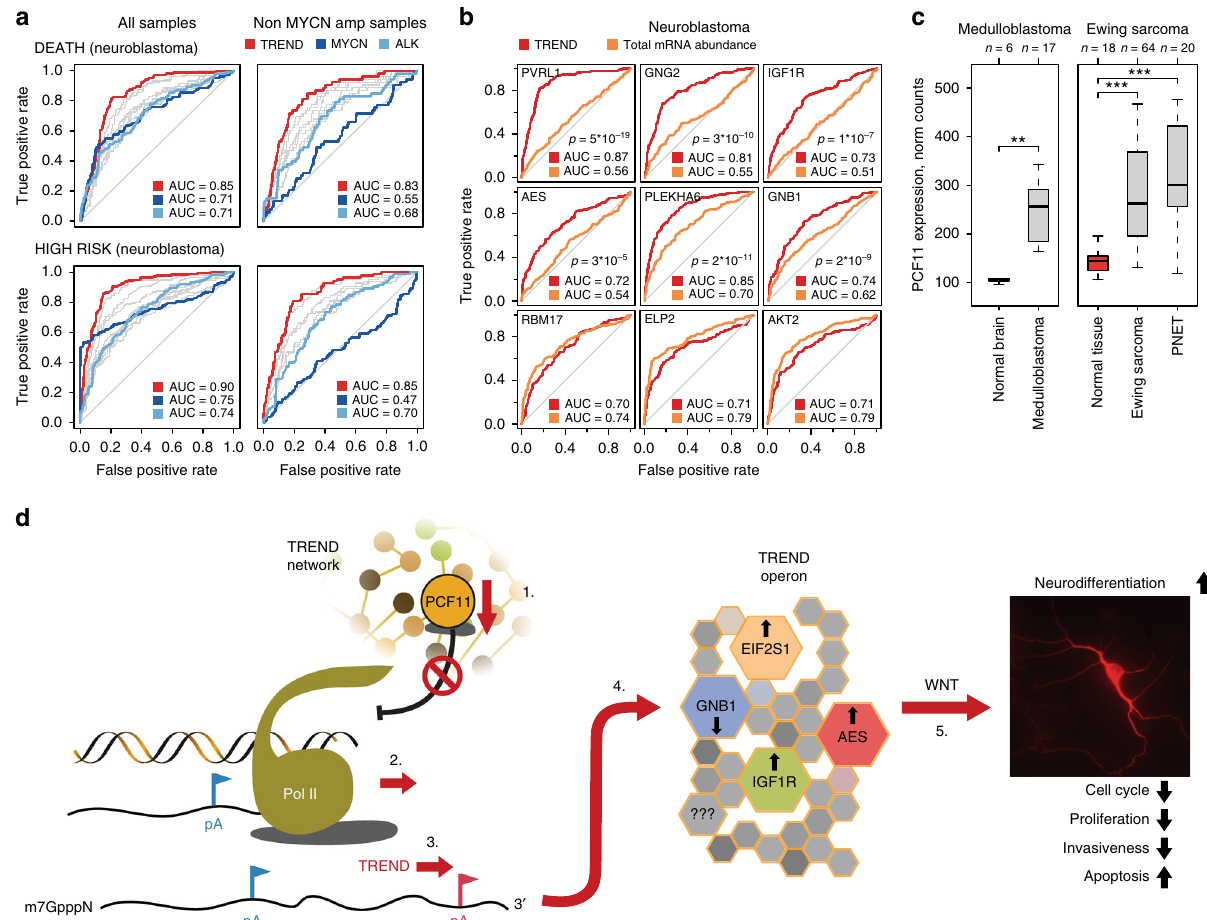
Fig. 7 PCF11-derived TREND signatures predict superior patient outcome. a Predictive potential of TREND signatures (red) compared to common strati fi ers in neuroblastoma (blue, Supplementary Table 6) with ( n = 493, left) or without ( n = 401, right) MYCN ampli fi cation ( p -values, Supplementary Table 7, Cox-modelling Supplementary Figure 7e). Receiver-operating characteristic (ROC) curve re fl ecting the ratio of short-to-long isoform abundance of PCF11- TREND-affected genes (with AUC > 0.7) for predicting death (upper panels) or association with high risk (lower panels). Red line depicts predictive power of a combined TREND pattern (multifactor ROC) compared to ROC based on expression of established risk markers (MYCN and ALK 82 ; grey lines re fl ect ROC for 3 ′ end isoform patterns of individual TREND-affected genes, GSE49710 44 ; Supplementary Table 6). b ROC curves re fl ecting TREND alterations (red) of genes belonging to the neurodifferentiation TREND operon highlight the predictive power of deregulated TREND signatures compared to the poor sensitivity and speci fi city of the mere mRNA abundance (orange; n = 493, raw data same as for a ; TREND isoforms and mRNA abundance of RBM17, ELP2 and AKT2 (lower row) serve as control con fi rming absence of analytical bias in favour of TREND). c High-level PCF11 mRNA expression in other paediatric malignancies with embryonic origin including medulloblastomas (GSE35493), Ewing sarcomas (GSE17679) and primitive neuroectodermal tumours (PNET, GSE17679) compared to respective controls (red; expression data obtained from R2 (http://r2.amc.nl)). For box plots, centre line depicts median, hinges show 25th and 75th percentile, whiskers depict interquartile range (IQR = 1.5), two-sided t -test. ** p < 0.01, *** p < 0.001. d Integrated model for PCF11-dependent TREND regulation in neuroblastoma governing neurodifferentiation (details see text). Brie fl y, (1) postnatal downregulation of PCF11 is believed to (2) reduce ef fi ciency of transcription termination 20,21 , facilitating (3) alternative polyadenylation (APA) at distal (3 ′ located) polyadenylation (pA) signals (red), affecting TREND of >900 RNAs (4). This includes a neurodifferentiation TREND operon (Fig. 3b), shaping (5) WNT signalling to induce neurodifferentiation. Conversely, sustained (postnatal) high-level PCF11 expression arrests neuronal precursors in an undifferentiated state by promoting polyadenylation at proximal pA (blue), thereby controlling protein output of the neurodifferentiation TREND operon. Transcript isoform regulation of GNB1, a modulator of various transmembrane signalling pathways 48 with a role in development 63 , malignant transformation 64 and neurodevelopmental disorders 65 is prerequisite for PCF11-dependent regulation of neurodifferentiation. Notably, GNB1 was previously identi fi ed as marker for